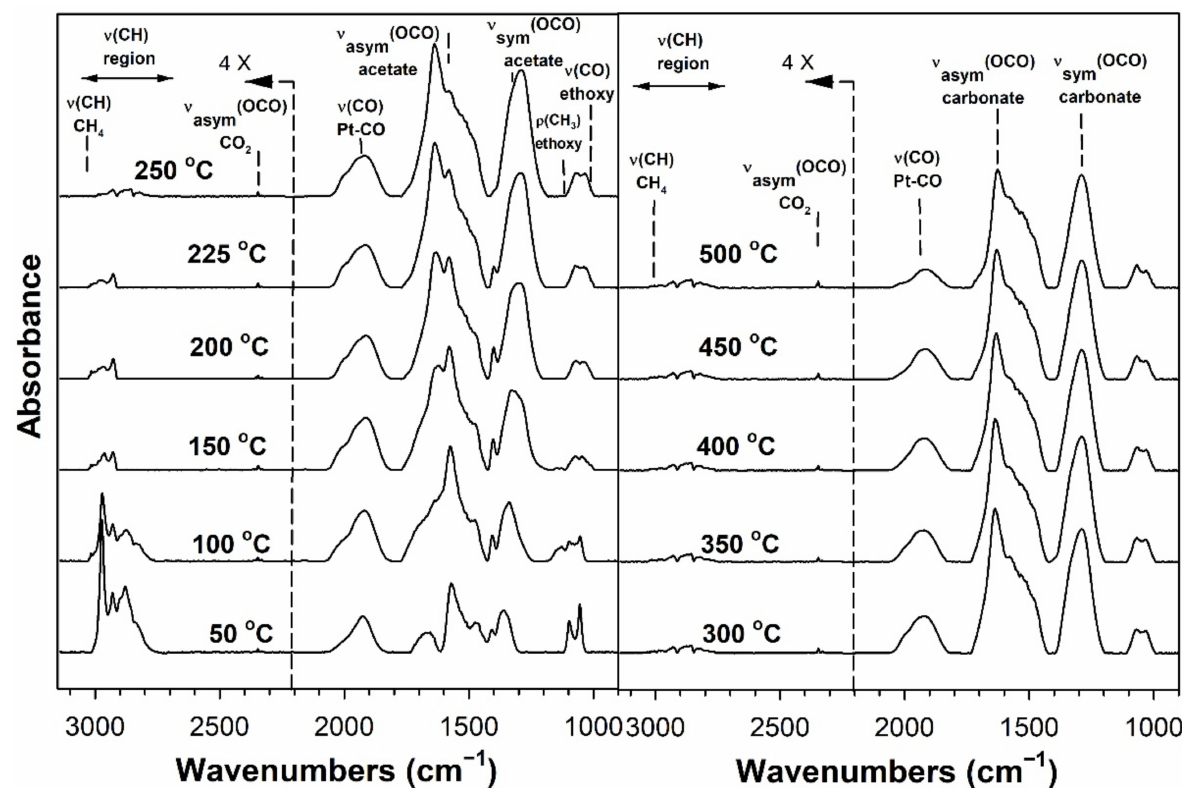
Figure 9. DRIFTS spectra of transient ESR over 0.93% Rb-2% Pt/m-ZrO 2 .